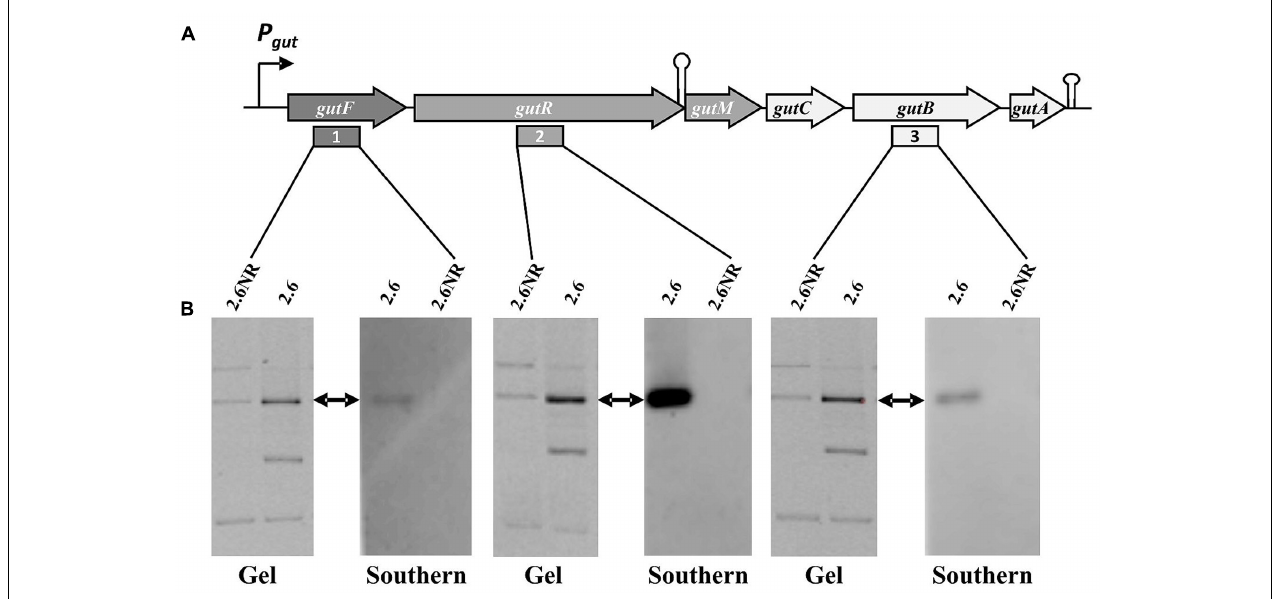
FIGURE 5 | Detection of the P. parvulus 2.6 gut operon by Southern blot hybridization. Plasmids preparations of the P. parvulus strains were fractionated by electrophoresis in agarose gel, transferred to membranes and hybridized for detection of gutF , gutR and gutB with the probes 1, 2, and 3, respectively. (A) Physical map of the gut operon, including the putative promoter of the gut operon (P gut ), the operon genes ( gutF, gutR, gutM gutC, gutB and gutA ), a secondary structure including the 3 (cid:48) -end of gutR and the 5 (cid:48) -end of gutM (coordinates 3483-3512 in GenBank accession No MF766019) as well as a transcriptional terminator (coordinates 6103-6027 in GenBank accession No MF766019) downstream of gutA. In addition, location of probes 1, 2, and 3 is indicated. (B) Images of the corresponding gels and hybridized membranes. The double headed arrows indicate the position of the hybridized bands in the corresponding